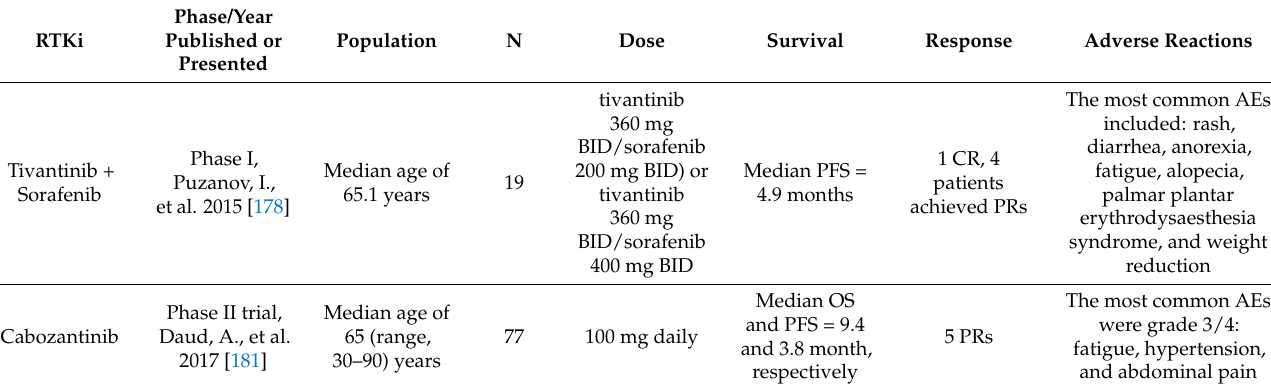
Table 9. Clinical trials with MET inhibitor in